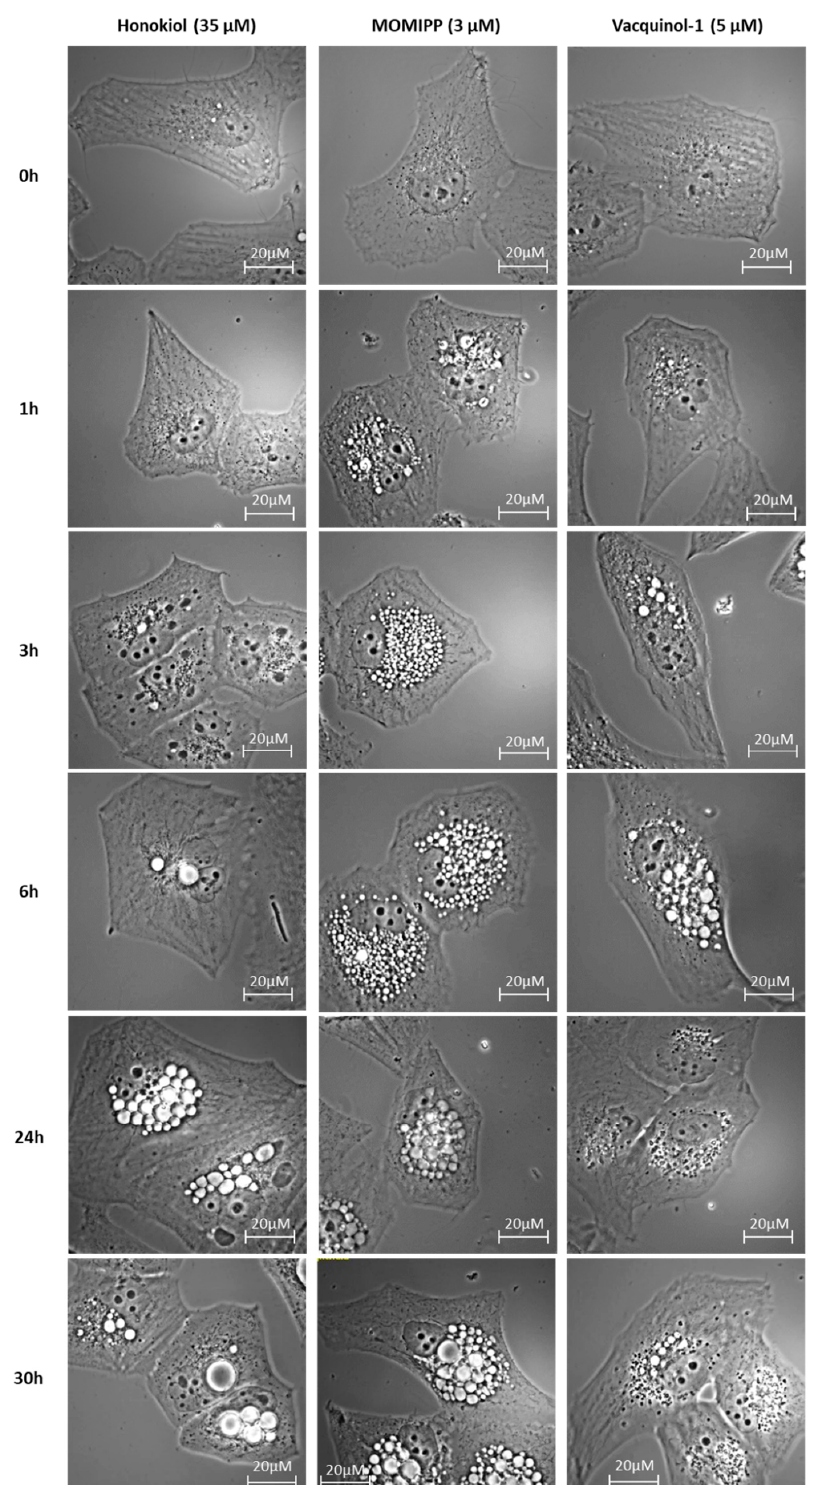
Figure 5. Morphological illustration of the vacuoles formed after treatment of the U373 cell line with honokiol (35 µ M), 3-(5-methoxy-2-methyl-1H-indol-3-yl)-1-(4-pyridinyl)-2-propen-1-one (MOMIPP) (3 µ M), or vacquinol-1 (5 µ M) over time. The accumulation of vacuoles is only visible after 24 h of treatment with honokiol, but those induced by treatment with vacquinol-1 occurs after 3 h and after only 1 h of treatment with MOMIPP. The experiment has been conducted two times in